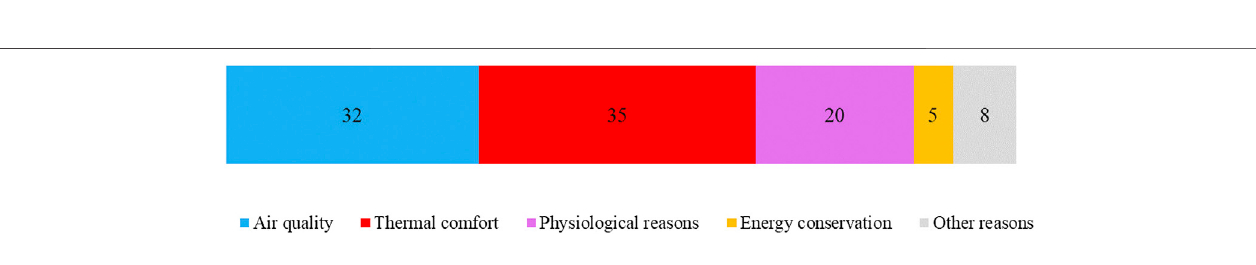
FIGURE 7 | Analysis of the reasons why occupants open